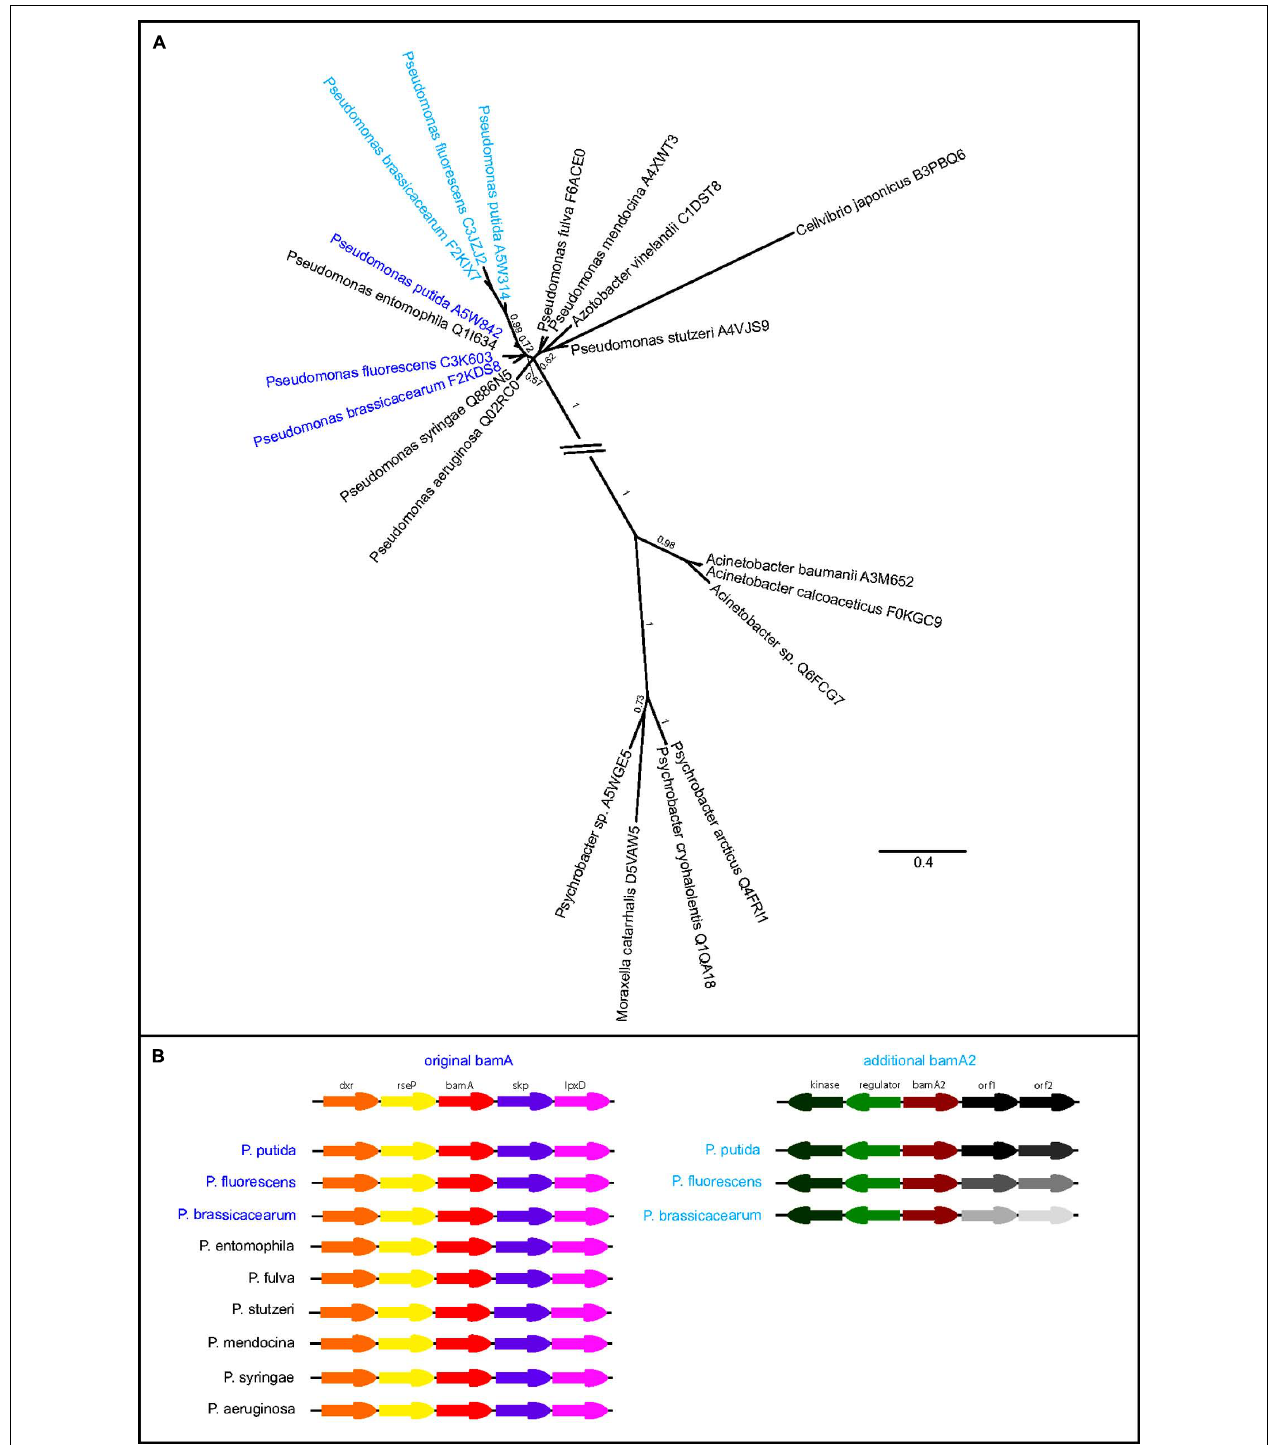
FIGURE 5 | Highly similar BamA paralogs in Pseudomonas spp. (A) Phylogenetic tree of the Pseudomonas spp. BamA sequences and their closest taxonomic relatives. Different colors indicate organisms with more than one BamA copy with dark blue displaying the original (most conserved) sequence, whereas additional copies are displayed in light blue.Tree calculations were performed using phylobayes under the C20 model,